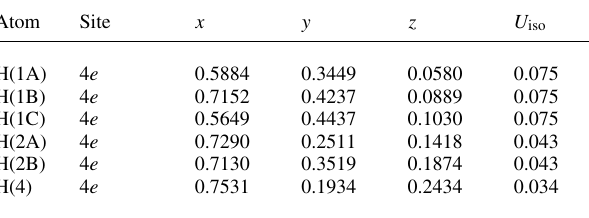
Table 2. Atomic coordinates and displacement parameters (in Å 2 )